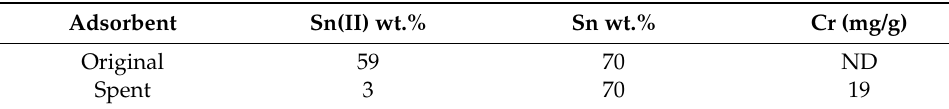
Table 1. Chemical analysis of original and spent adsorbent.